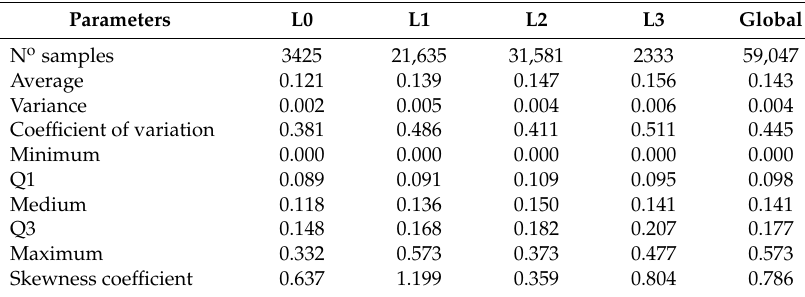
Table A2. Stope vein proportion statistics.